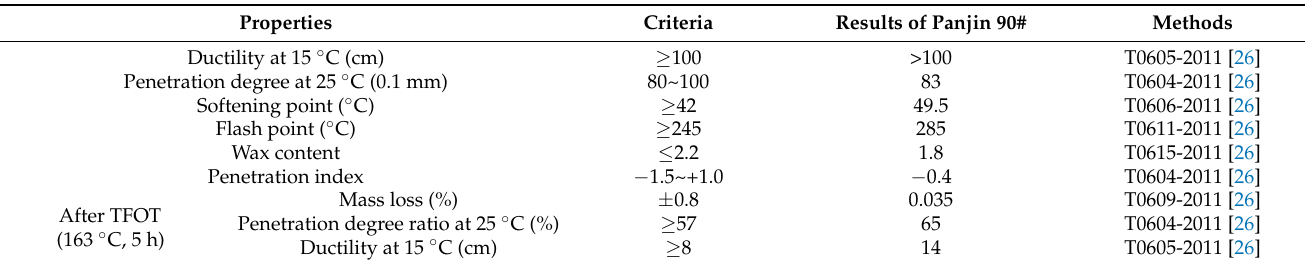
Table 1. Properties of base asphalt.